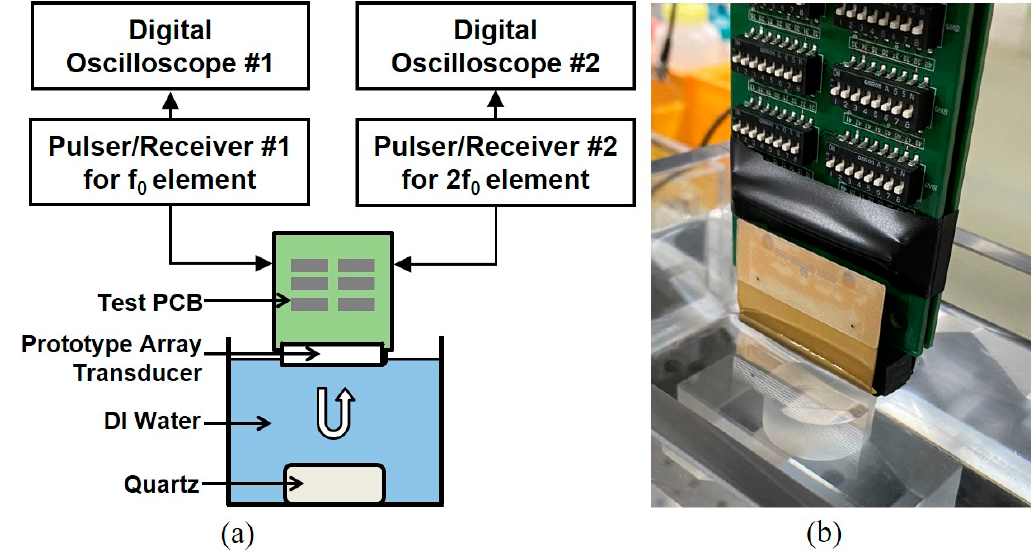
Figure 8. Experimental setup for pulse–echo measurement. Two pulsers/receivers were used for independent pulse–echo test of each element and the test for transmitting f 0 and receiving reflected 2f 0 frequency components: ( a ) Schematic diagram and ( b ) photograph of ( a ).